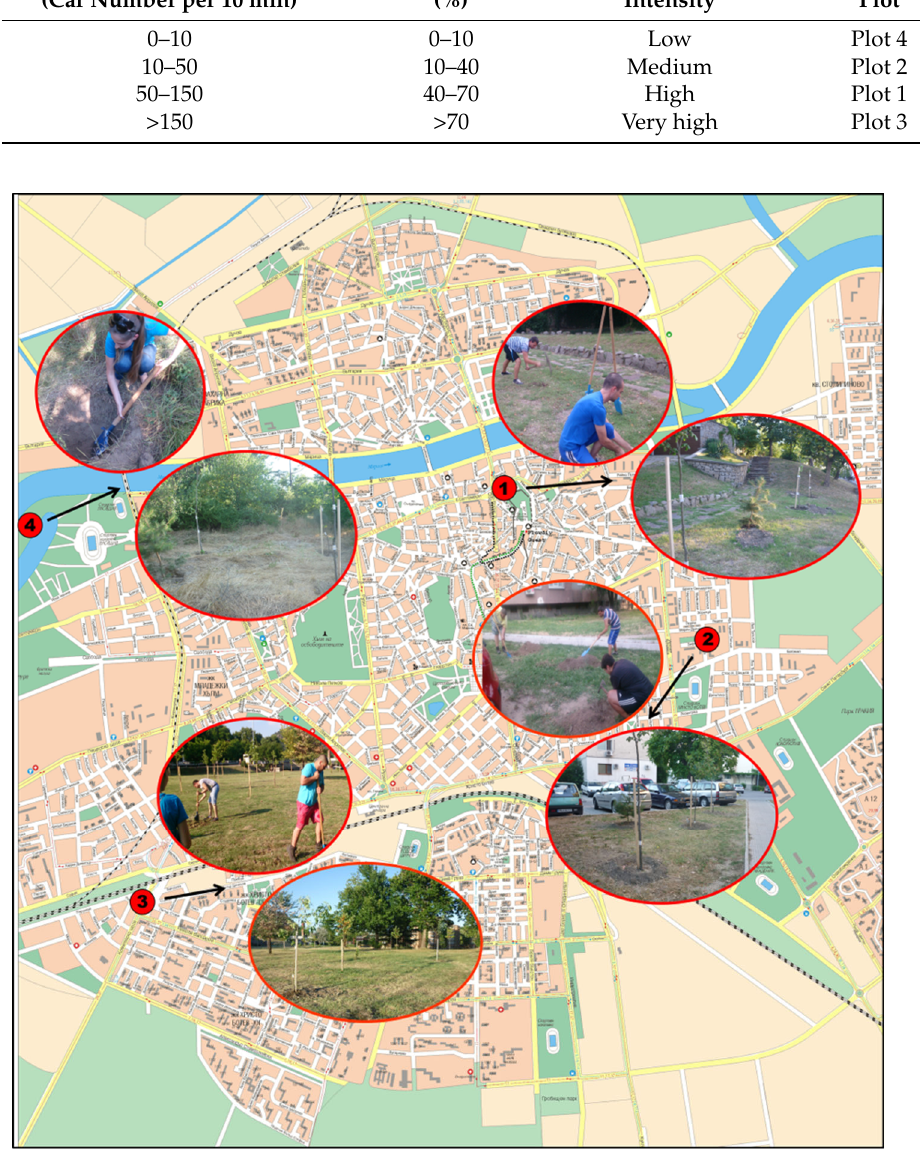
Figure 1. Map of the city of Plovdiv (Bulgaria), locations (numbered red dots), and photos of the four experimental plots (black arrows connecting to the locations). Table 1. Urbanization intensity evaluated on the basis of built-up area and tra ffi c volume.